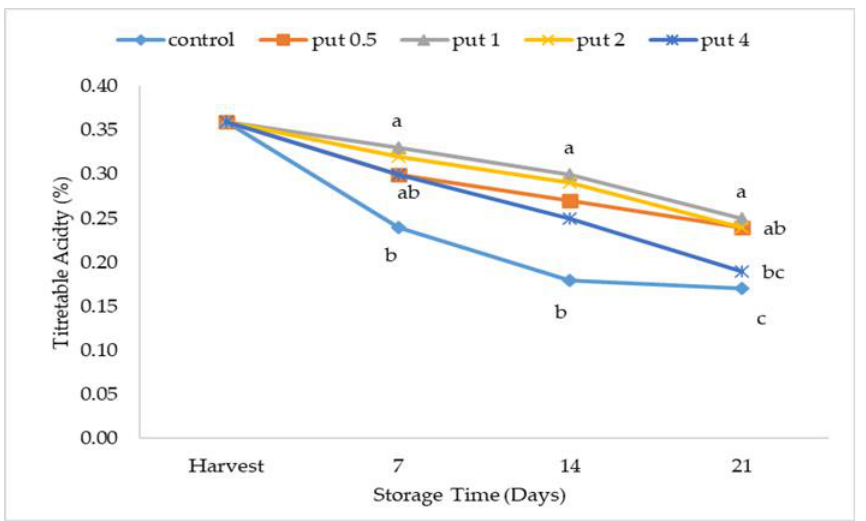
Figure 5. Effect of putrescine treatment on titratable acidity of fig fruit during cold storage. Put 0.5, 1, 2 and 4 indicates putrescine doses of 0.5 mM, 1 mM, 2 mM, and 4 mM, respectively. According to the Tukey test, p < 0.05 does not differ between the same letters in the same harvest period.